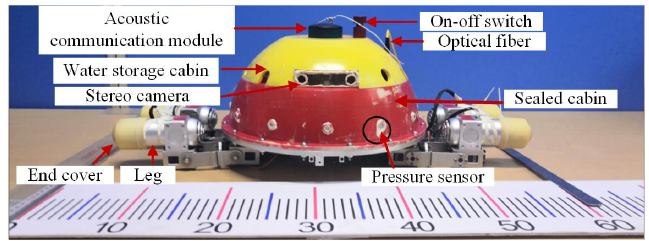
Figure 1. The prototype of the biomimetic spherical robot.